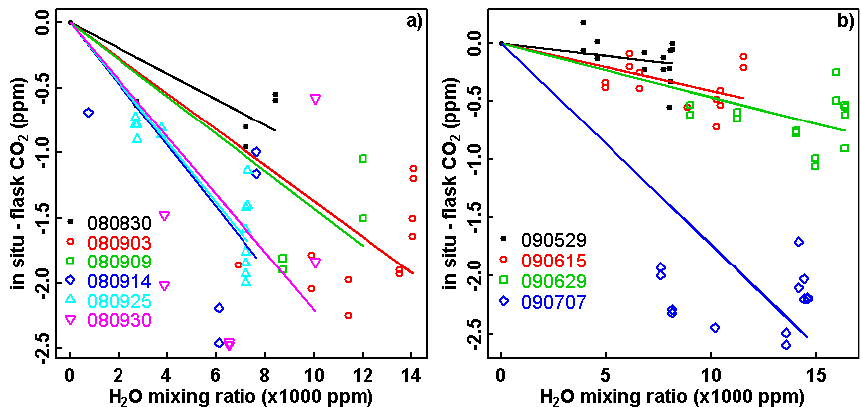
Fig. 10. Linear regression models are fitted per flight using the least squares approach for the differences between in situ and flask CO 2 as a function of water vapor mixing ratios. The differences between in situ and flask CO 2 are denoted by different colors for each flight in the plots. Panels (a) and (b) show two periods during which the in situ measurements of CO 2 mixing ratios have been affected by residual water vapor in the sampling air after the chemical dryer.